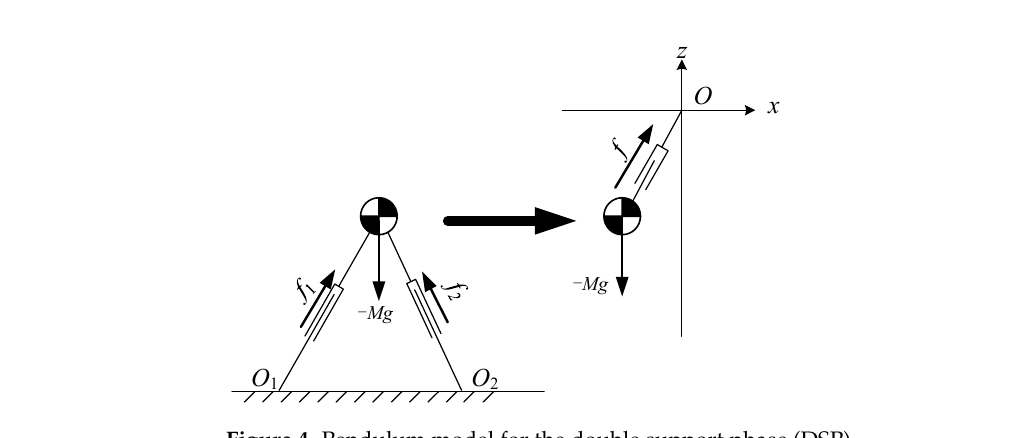
Figure 4. Pendulum model for the double support phase (DSP).